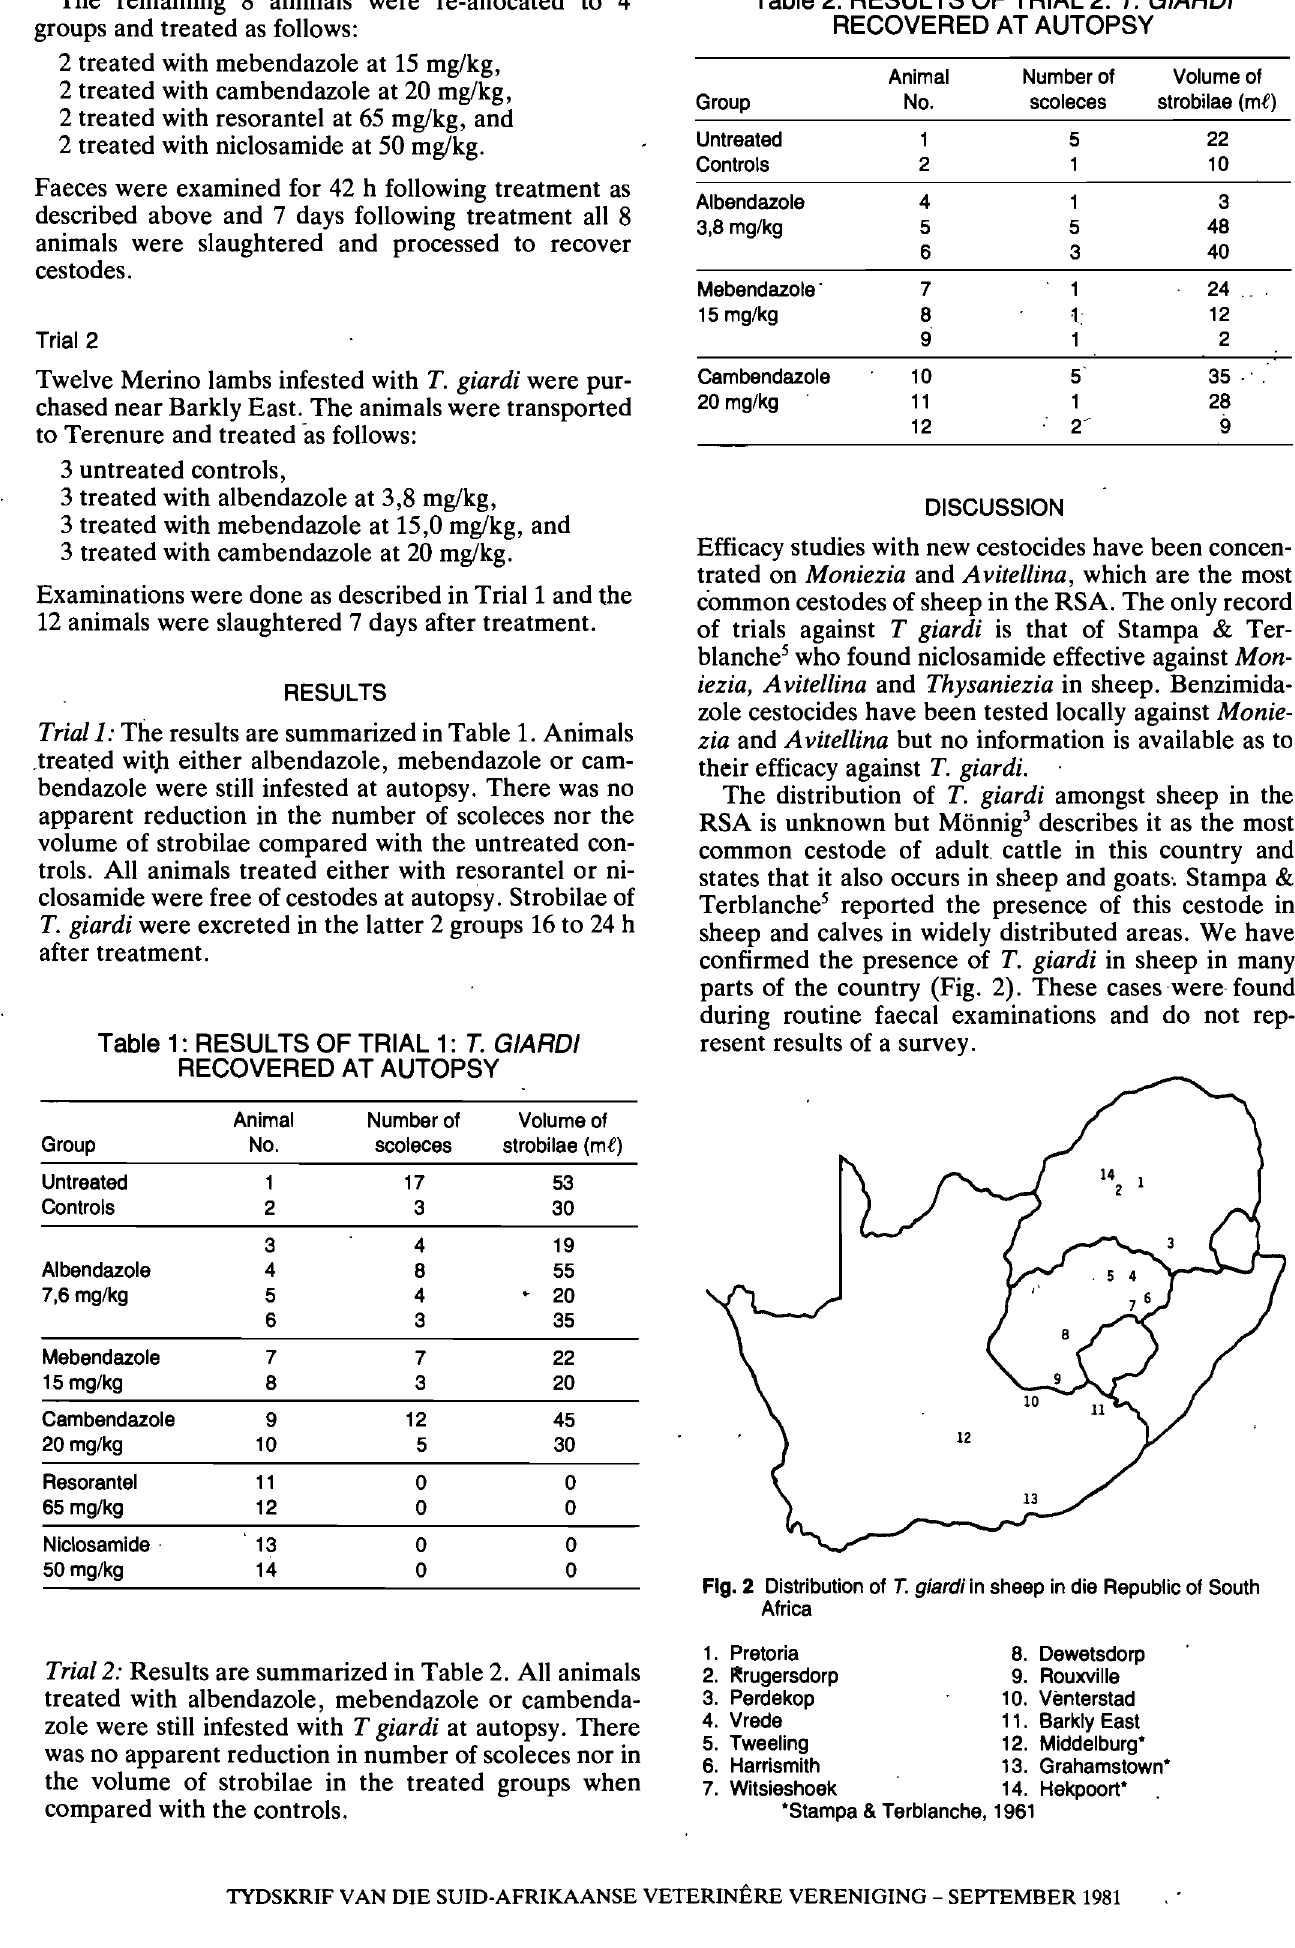
Fig. 2 Distribution of T. giardi in sheep in die Republic of South